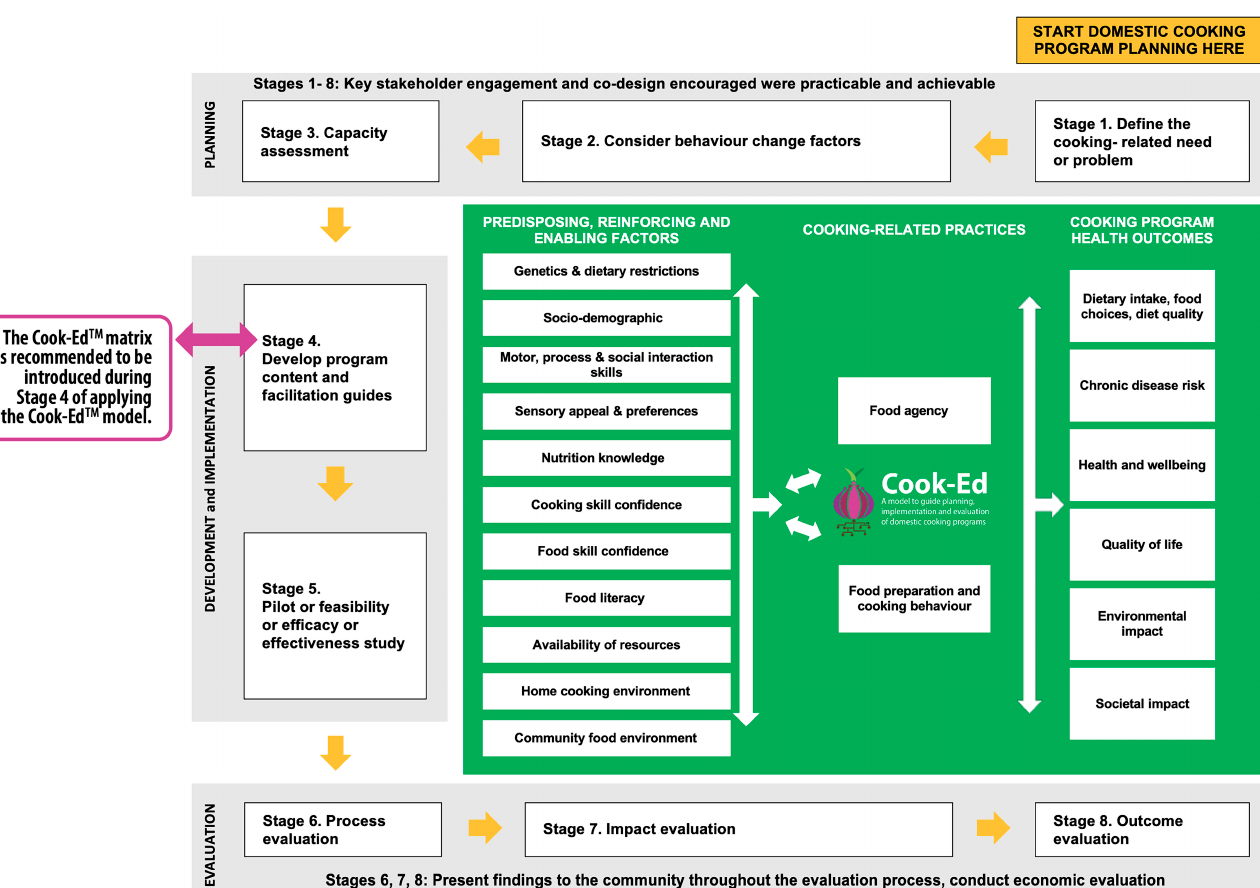
Figure 2. Illustration showing where to introduce the Cook ‐ Ed TM matrix when applying the Cook ‐ Ed TM model